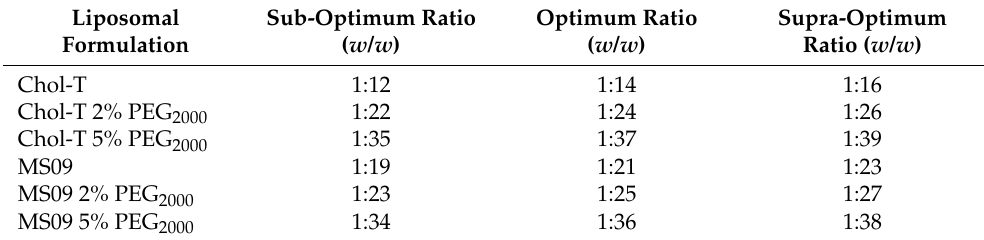
Table 3. Lipoplexes at the sub-optimum, optimum and supra-optimum ratios ( w / w ). Liposomal